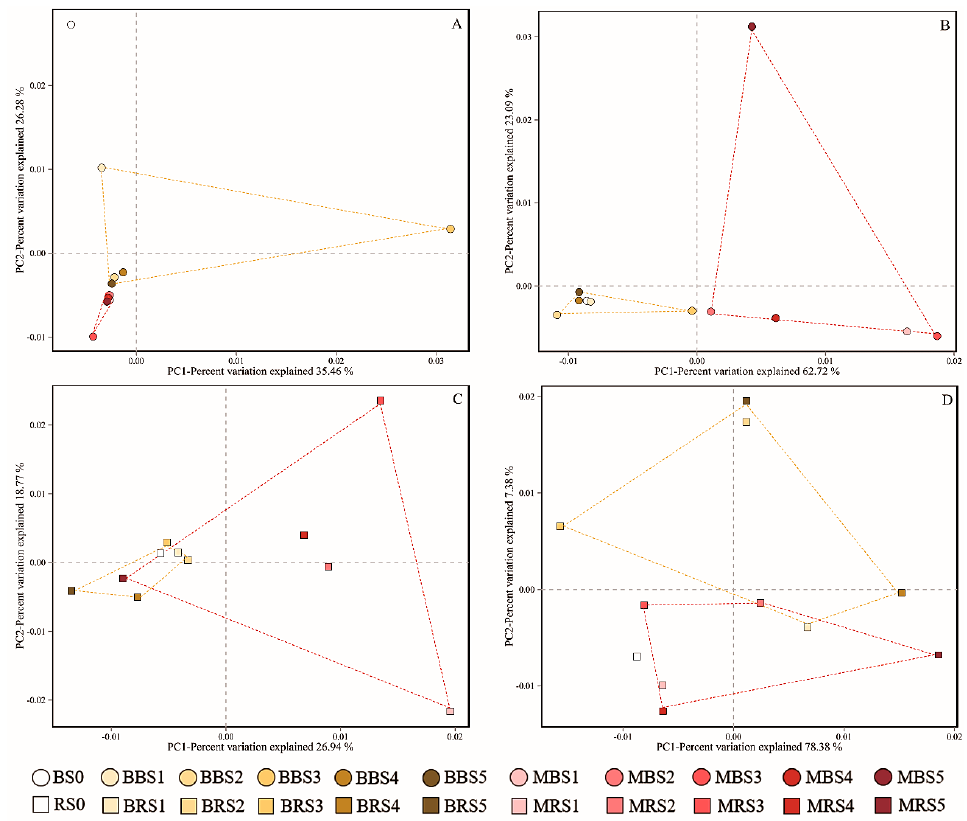
Figure 8. Principal component analysis (PCA) plot of all soil fungal and bacterial communities. ( A , B ) The PCAs of the fungal and bacterial communities in bulk soil at OTU level, respectively; ( C , D ) the PCAs of the fungal and bacterial communities in rhizosphere soil at OTU level, respectively; B and M indicate bamboo biochar and bacteria-inoculated biochar; BS and RS indicate bulk soil and rhizosphere soil; 0, 1, 2, 3, 4, and 5 indicate control, 2.22 t·ha − 1 , 4.44 t·ha − 1 , 6.67 t·ha − 1 , 8.89 t·ha − 1 , and 11.11 t·ha − 1 .